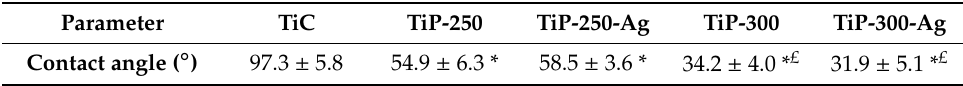
Figure 3. Exemplary EDX mapping of element distribution on the PEO layer in NTA-containing solution (upper row) and after Ag nanoparticles (AgNP) doping (lower row): images represent 300 V mode. Table 2. The results of contact angle measurement.